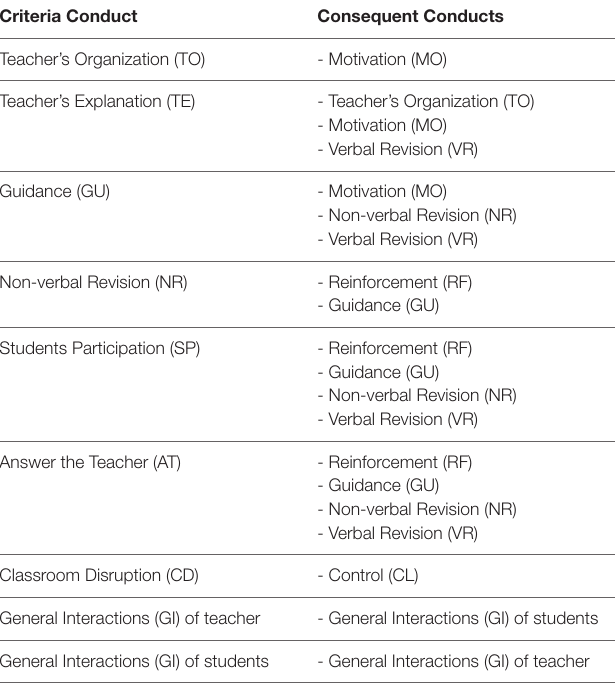
TABLE 3 | Behavioral patterns considered good teaching